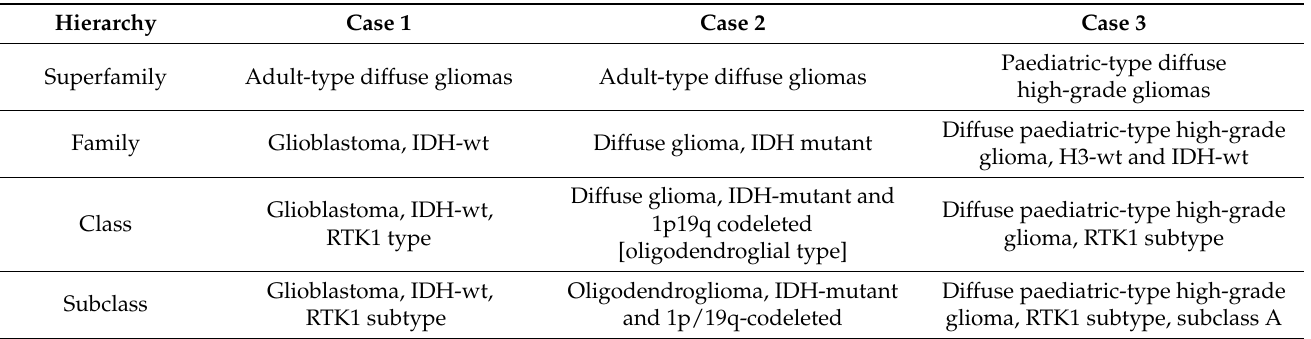
Table 1. The four levels of hierarchy according to v12.5 of the MNP classifier for three cases